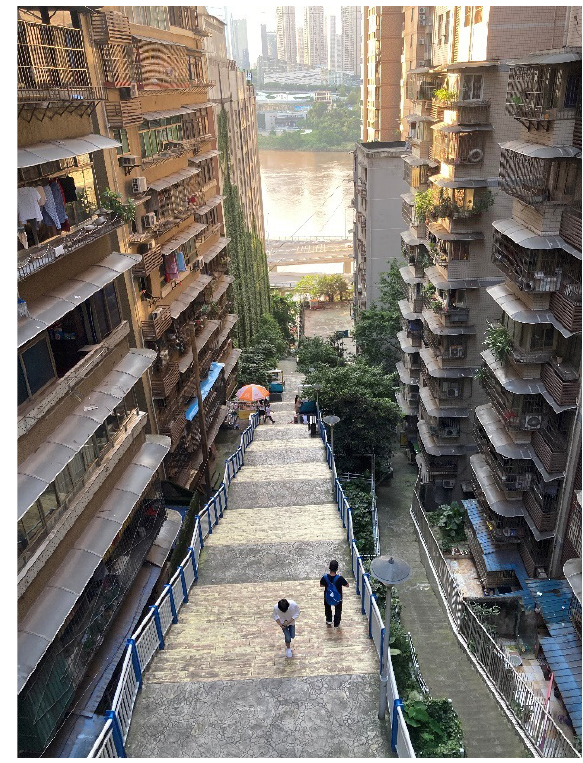
Figure 9. Qiansi Gate–Huguang Guild Hall